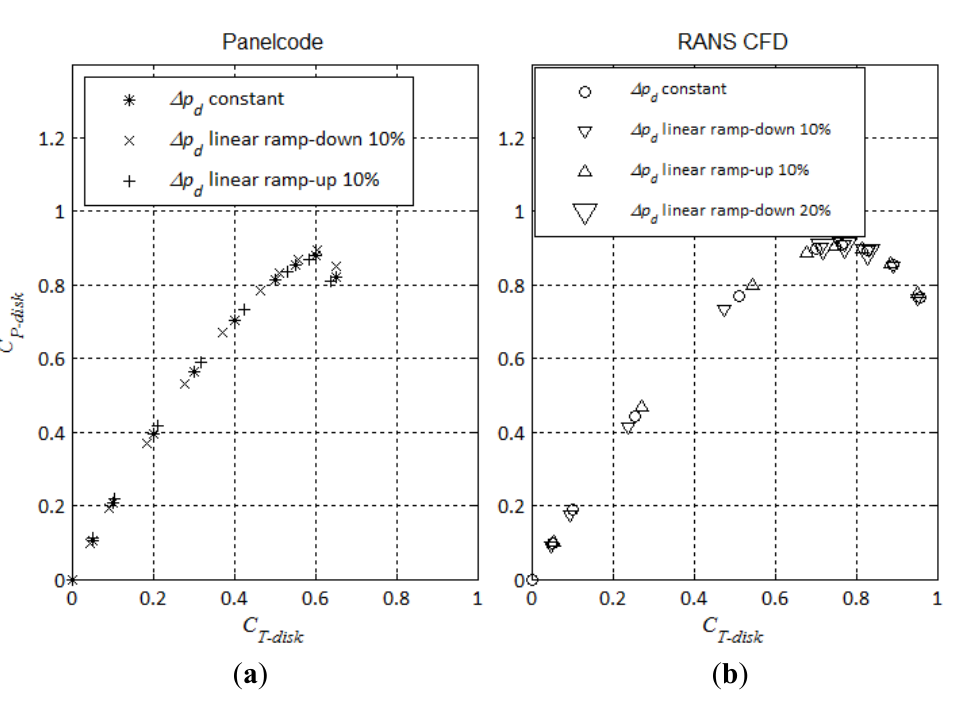
vs. (cid:1829) for non-uniform loading. ( a ) Panel code results; ( b ) RANS Figure 5. (cid:1829) (cid:3021)_(cid:3031)(cid:3036)(cid:3046)(cid:3038) (cid:3017)_(cid:3031)(cid:3036)(cid:3046)(cid:3038) CFD